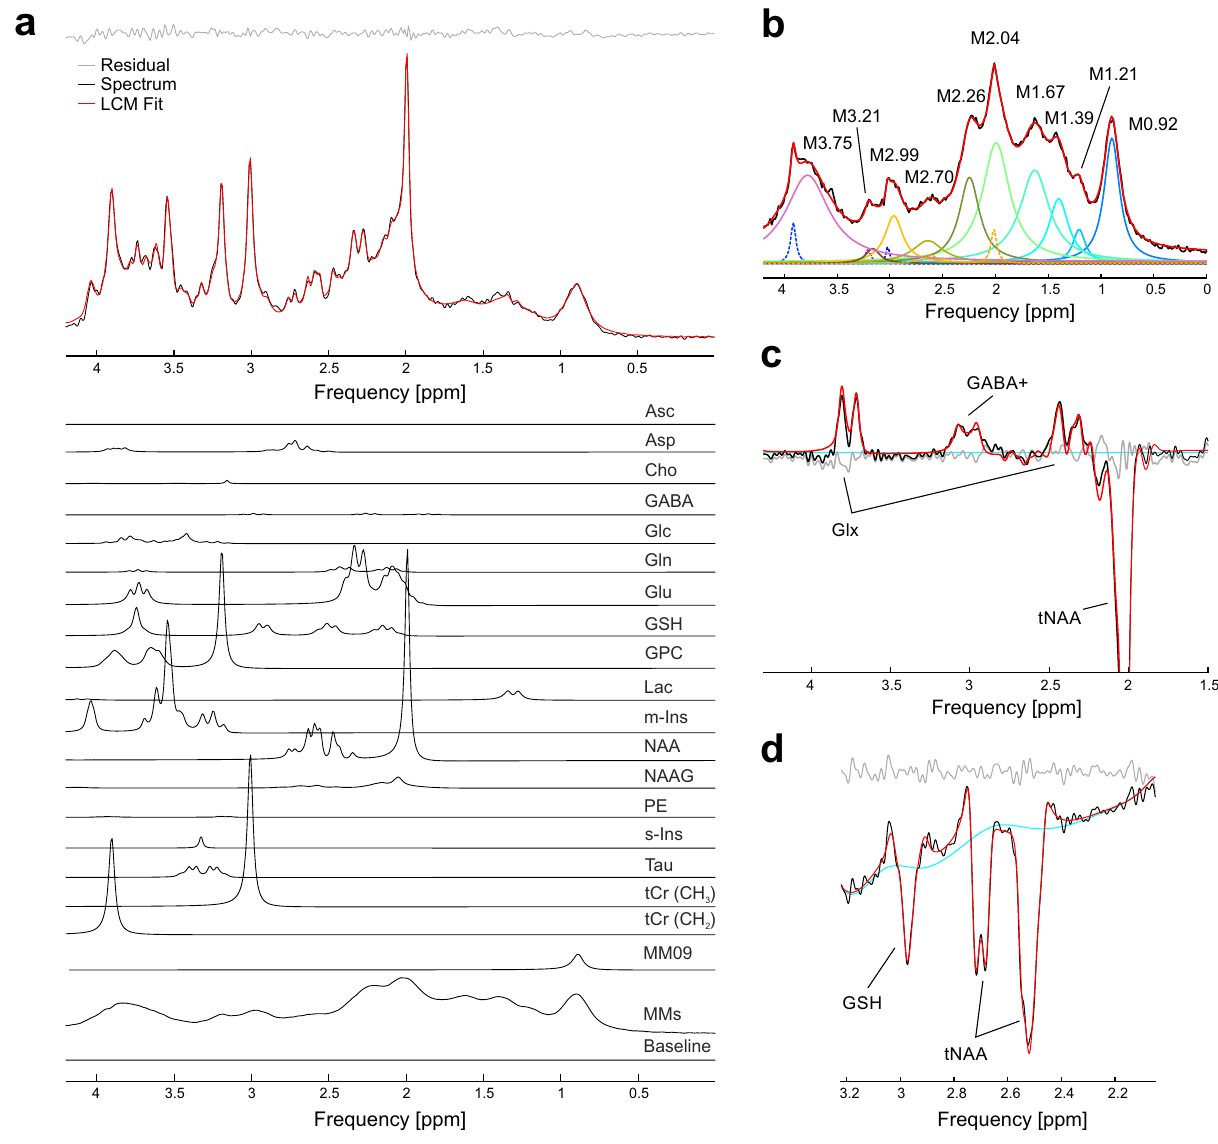
Figure 7. Linear combination modeling (LCM) analysis of in vivo 1 H MR spectra of the human brain. The LCM fit of all signals is in red. ( a ) Spectrum from medial prefrontal cortex with fit and scaled basis functions. The measured macromolecular signal was included in the basis set. The “MM09” basis function compensated offsets caused by macromolecular signal variation due to differences in T 1 relaxation times among different macromolecules. Data were measured in a healthy adult at 3 T 3 . ( b ) Analysis of macromolecule spectrum measured in the medial prefrontal cortex at 3 T 43 . The spectrum was obtained from the occipital lobe of a healthy volunteer and shows 10 broad macromolecule resonances (solid colored lines), along with 3 residual singlet resonances assigned to the metabolites NAA (orange), creatine (blue), and choline (purple). ( c ) J -difference edited spectrum for gamma-aminobutyric acid (GABA) quantification from the medial prefrontal cortex measured at 3 T (unpublished data). GABA+ denote possible macromolecular contamination due to co-editing effect. ( d ) J -difference edited spectrum for glutathione (GSH) from the prefrontal cortex resembling the first successful implementation of MEGA semi-LASER at 7 T 42,44